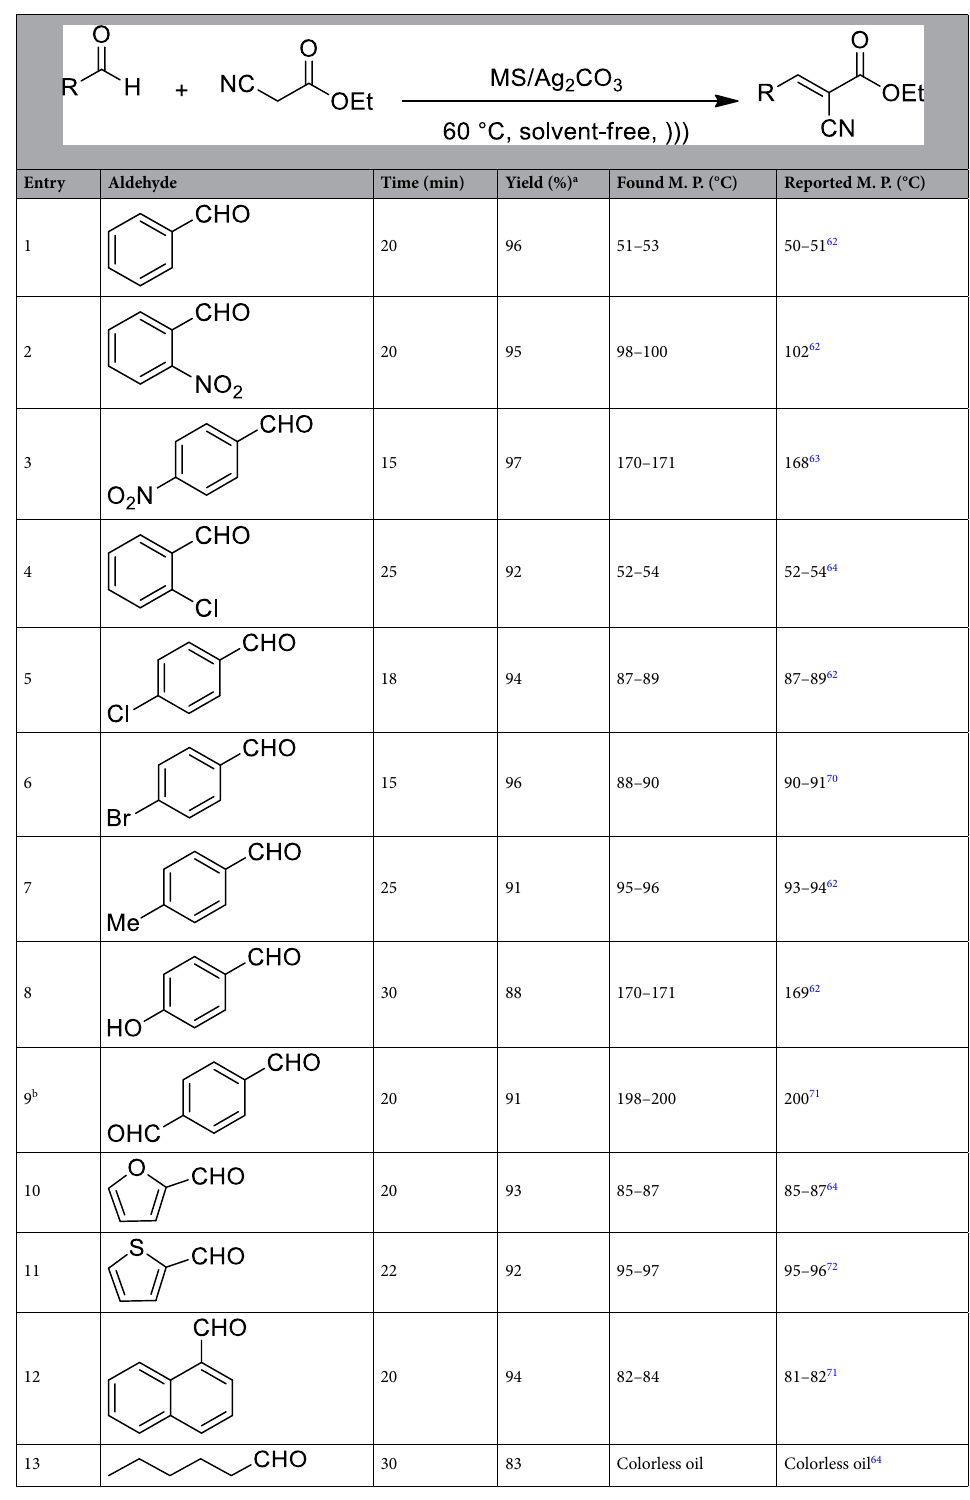
Table 2. Preparation of the Knoevenagel products using MS/Ag 2 CO 3 . a Isolated yields. b Ethyl cyanoacetate (2